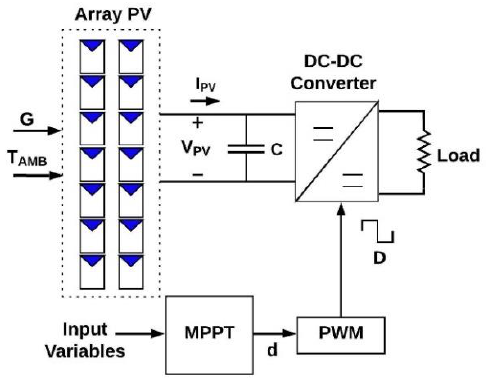
Figure 1. PV system.